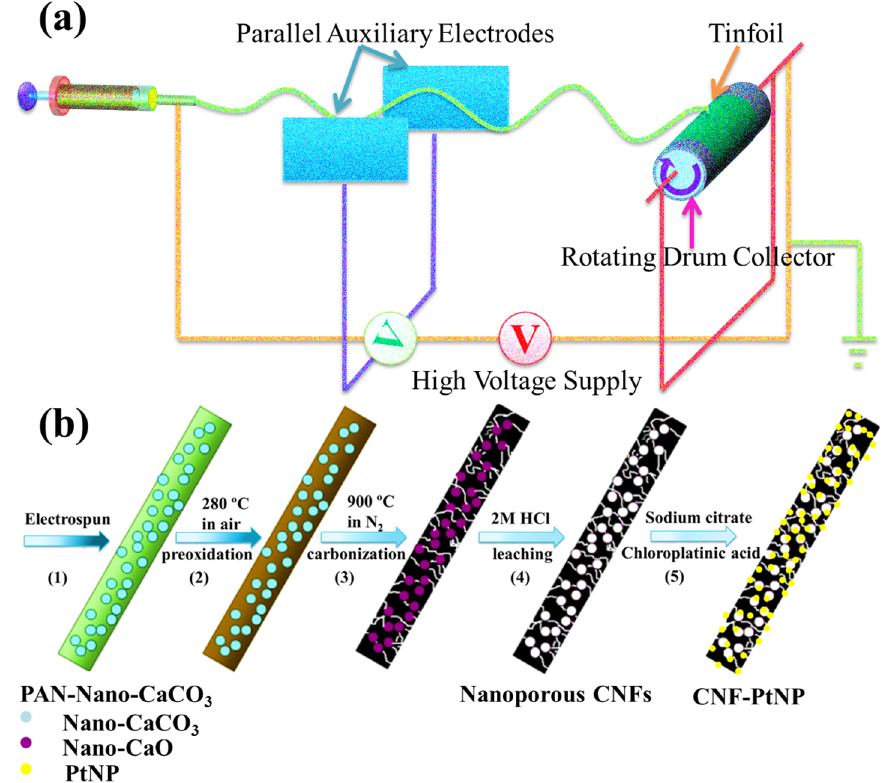
Figure 1. Schematic presentation on: ( a ) The electrospinning apparatus for preparing the polyacrylonitrile (PAN)-CaCO 3 nanofibers (NFs); and ( b ) Preparation of nanoporous carbon nanofibers (CNFs) decorated with platinum nanoparticles (PtNPs) (CNF-PtNP)